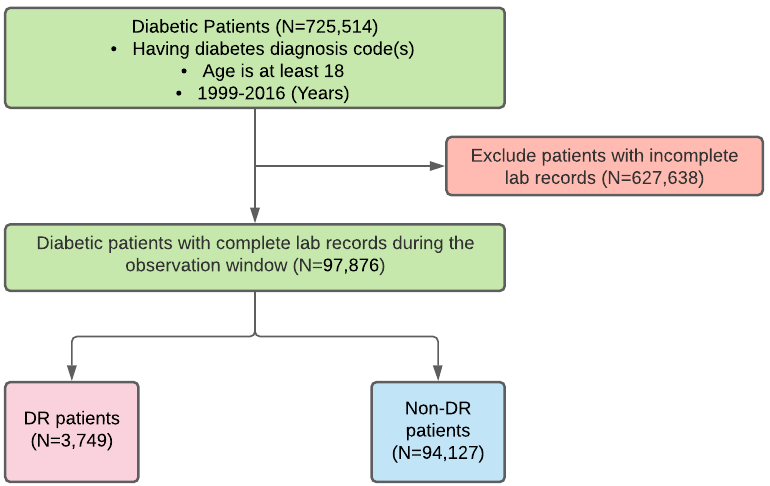
Figure 3. The workflow for the derivation cohort development.